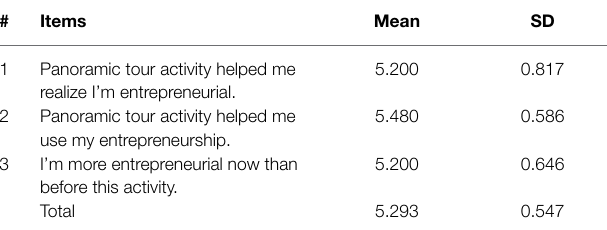
TABLE 6 | Perceived changes in entrepreneurship.